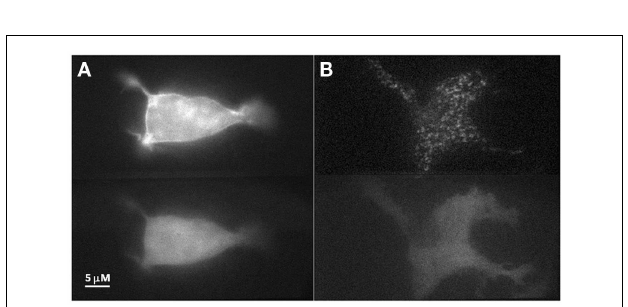
FIGURE 2 | Co-translocation of Doc2B wt –mRFP and Munc13-1 wt –EGFP in theTIRF plane . (A) TIRF images of a PC12 cell expressing Munc13-1 wt –EGFP (upper panel) and Doc2B wt –mRFP (lower panel). From left to right: basal state, beginning of translocation, maximum translocation, and back to basal state. (B) Quantification graph of the translocation kinetics observed in the cell’s lower PM. Red line indicates Doc2B wt –mRFP, green line indicates Munc13-1 wt –EGFP ( n = 13).Yellow arrows indicate KCl application.